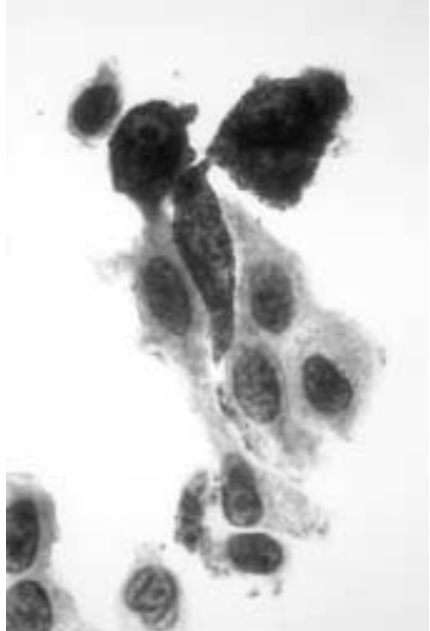
Fig. 2. Brushing smear from a conjunctival malignant melanoma. Polymorhous tumor cells containing cytoplasmatic melanin. Magni- fication 63 × .